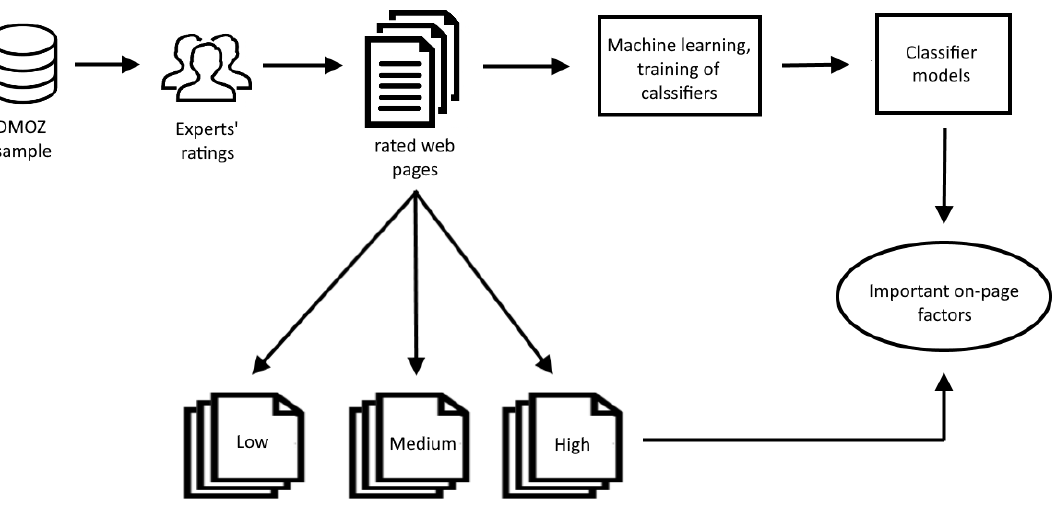
Figure 1. Research workflow.